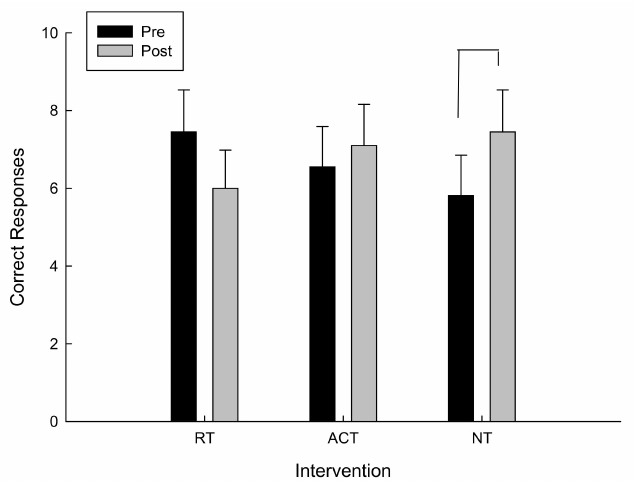
Figure 4. Correct moves as a function of time and intervention.